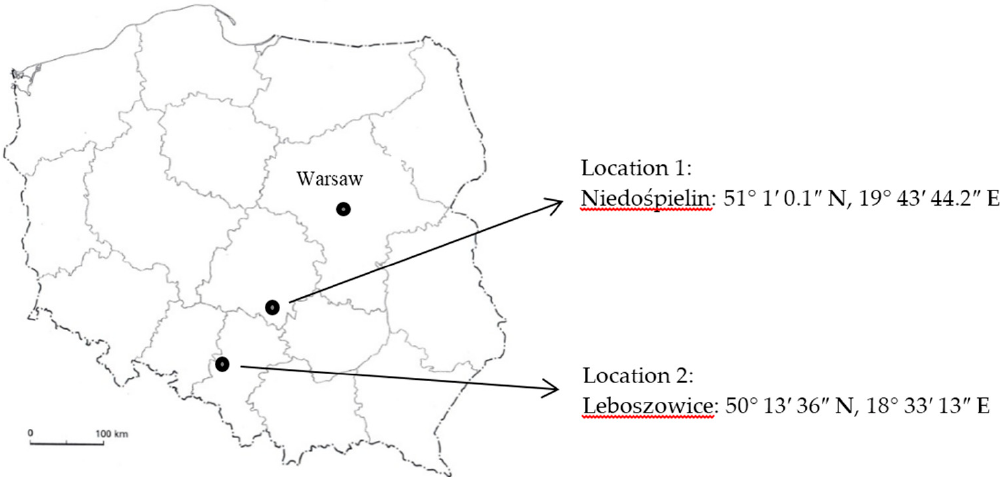
Figure 1. Plant collection area, Poland.